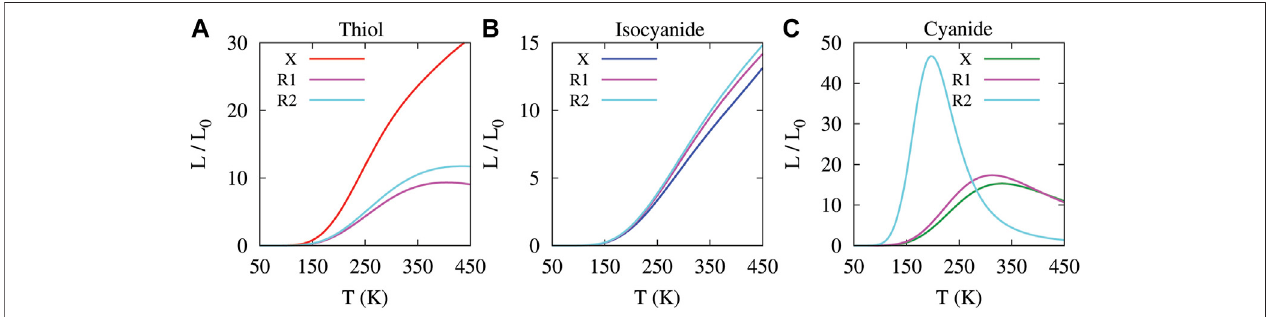
FIGURE 8 | Lorenz ratios defined by Eq. 11 as a function of temperature for the unperturbed (labeled X) molecule and the molecule perturbed with the amine side group in R1 and R2 positions. The coupling of the molecule to the Au electrodes was mediated by thiol (A) , isocyanide (B) and cyanide (C) anchoring groups.